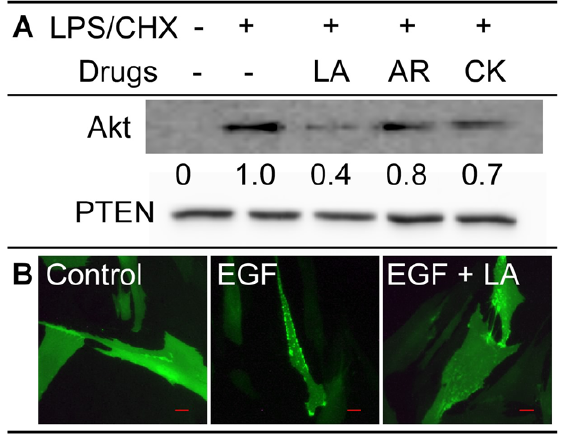
Figure 6. Determining the effects of the screened compounds on membrane localization of Akt. ( A ) Tat-expressing CHME5 cells were treated with 20 m M of the different drugs and LPS/CHX before having compartmental protein extraction done. Membrane fractions were then analyzed by western blot analysis for total Akt level. PTEN was used as an internal loading control, since it is present on the membrane and its level does not change under different treatment conditions (Figure 4B). ( B ) Human lung fibroblasts were transduced with Adenoviral vectors containing eGFP (control) or PH-Akt-eGFP and were treated with epithelial growth factor (EGF). Control cell picture (control) is eGFP. EGF picture is Akt-PH-eGFP expressing cells. EGF + LA picture is Akt-PH-eGFP expressing cells treated with Lancemaside A1. Akt-PH-eGFP localization to the plasma membrane was determined using a fluorescence microscope. Red scale bar indicates 20 m m distance.